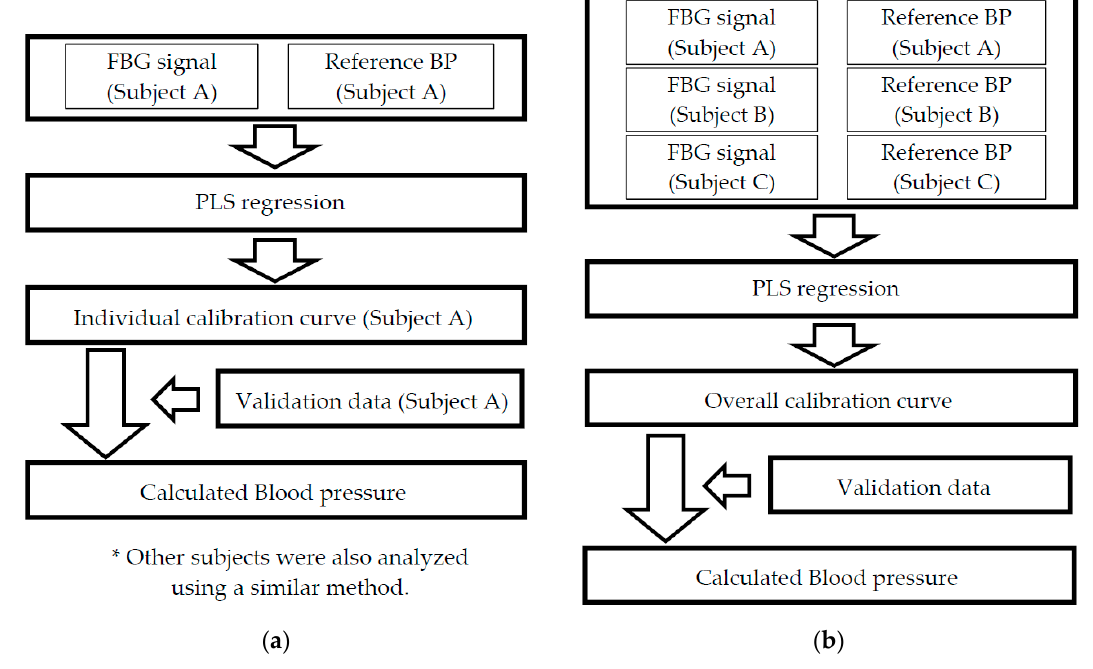
Figure 4. The block diagram of each calibration curve constructing method: ( a ) the method of constructing an individual calibration curve; and ( b ) the method of constructing the overall calibration curve.